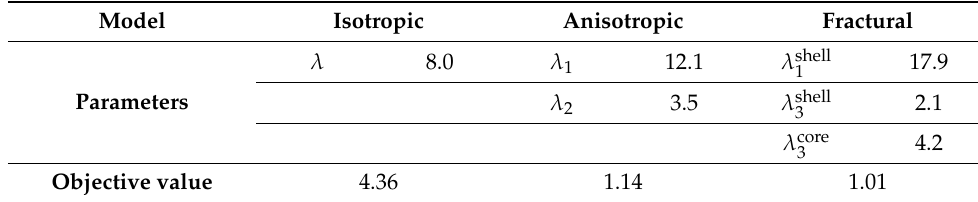
Figure 12. Temperature fields of optimized numerical models. Isotropic approach ( top left )— T min = 43 ◦ C, T max = 77.3 ◦ C, anisotropic ( top right )— T min = 45.6 ◦ C, T max = 78.6 ◦ C, fractural ( below )— T min = 45.3 ◦ C, T max = 78.5 ◦ C. Table 2. Results of the inverse task for the presented thermal conductivity approaches. Values of conductivities are in W/m·K.